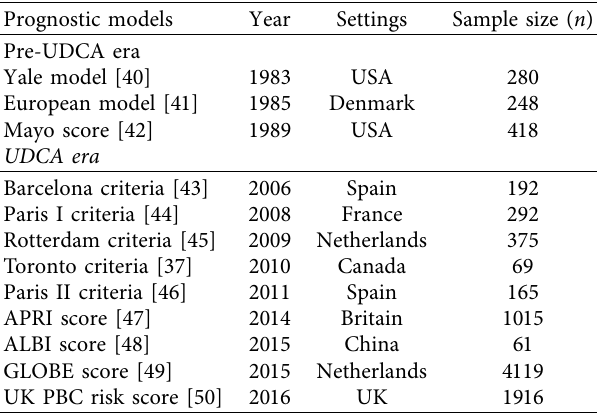
Table 1: Prognostic models for